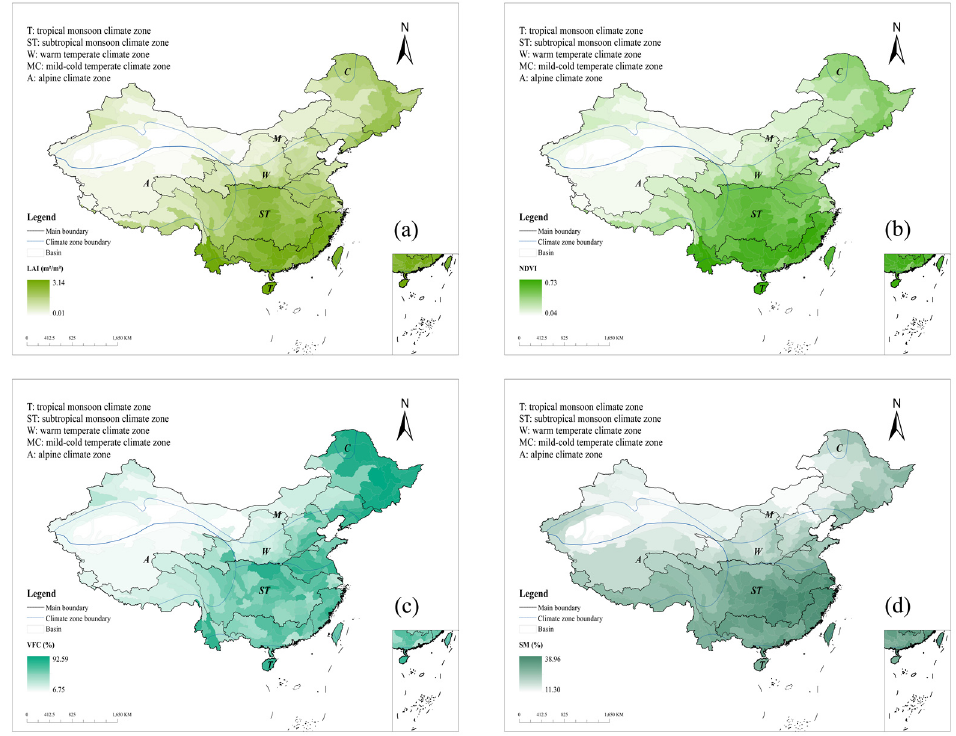
Figure A2. The spatial distributions of long-term ( a ) LAI; ( b ) NDVI ; ( c ) VFC ; and ( d ) SM.